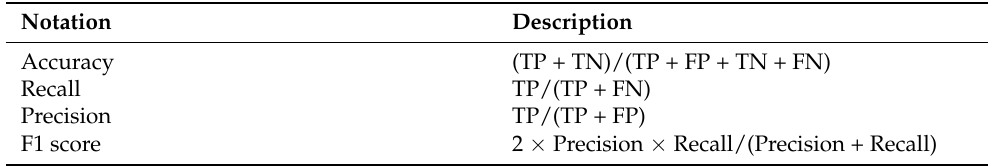
Table 5. Performance metrics for imbalanced learning.